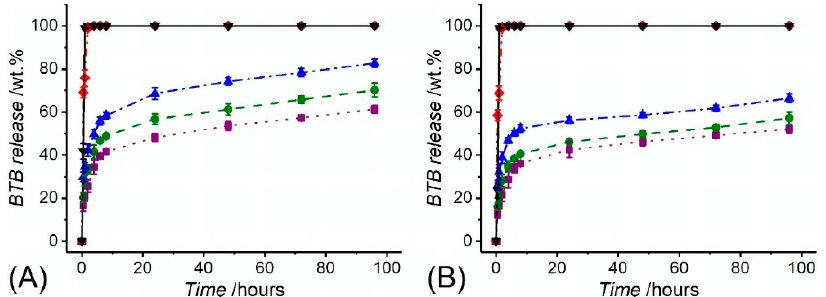
Figure 8 . BTB release measured in varied buffer solutions from core ‐ shell fibre samples CS ‐ PAA12 ‐ (PMMA ‐ co ‐ MAA) ( A ) and CS ‐ PAA10 ‐ (PMMA ‐ co ‐ MAA) ( B ). ( ∙∙ ■ ∙∙ ): pH 5; ( ‐‐●‐‐ ): pH 6; ( ─ ∙ ▲ ∙ ─ ): pH 7; ( ─ ∙∙ ♦ ∙∙ ─ ): pH 7.4; ( ─▼─ ): pH 8.